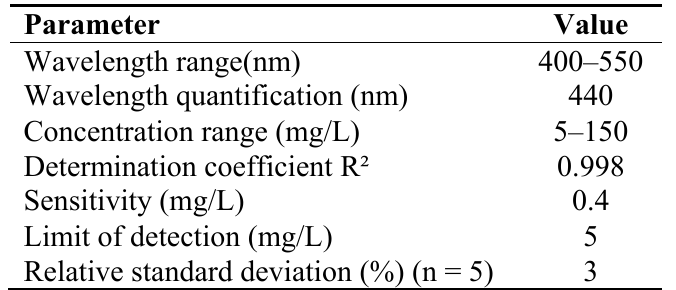
Table 1. Characteristics of the UV-vis spectroscopic method for the determination of